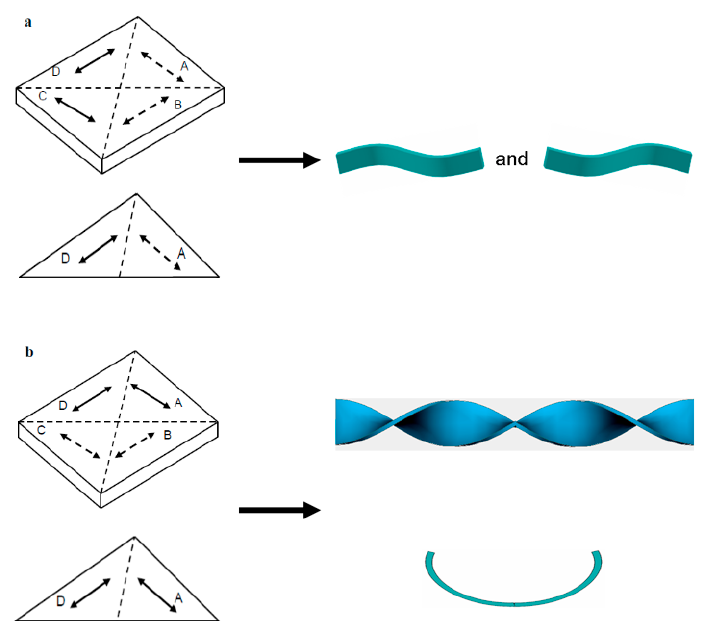
Figure 18. Two possible distributions of surface stresses in lamella of nonchiral polymers. The black solid and dashed arrows indicate the net tensile stress on the top and bottom surface of the lamella, respectively. The case ( b ) rather than the case ( a ) leads to lamellar twisting. Adapted with permission from Ref. [15]. Copyright (2010) American Chemical Society.